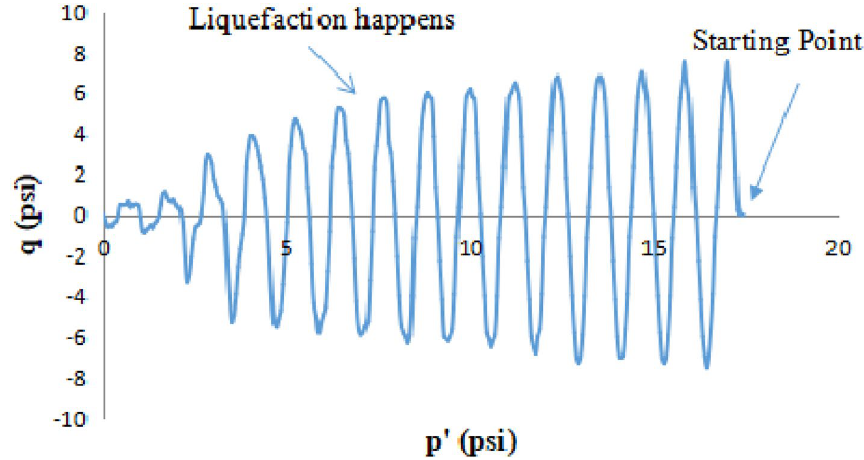
Figure 14. p ′ versus q stress path in cyclic triaxial test.